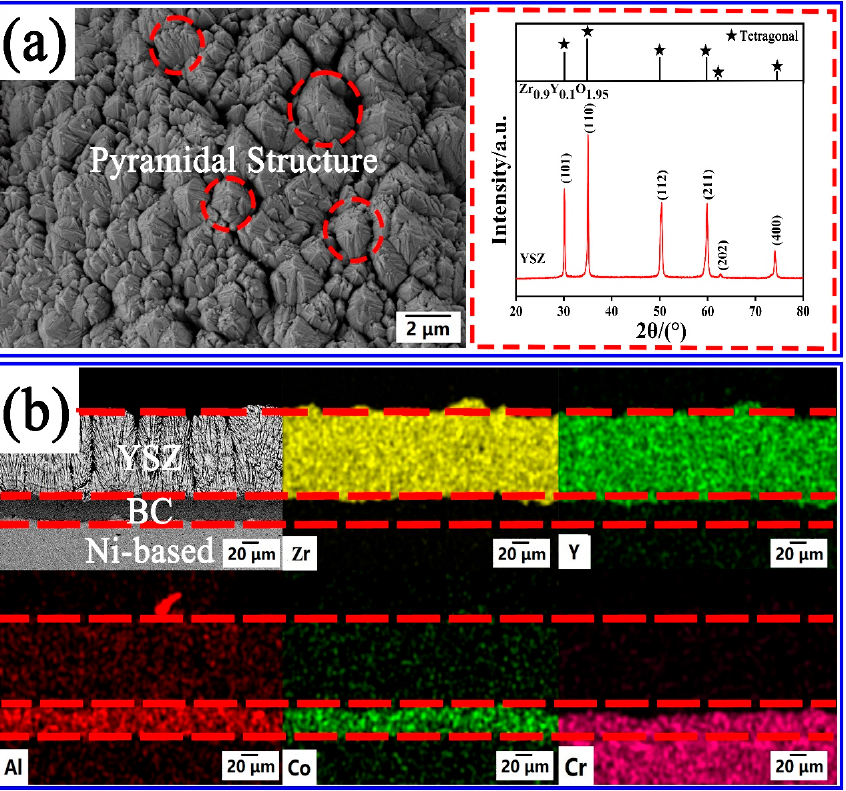
Figure 2. Characterization results of YSZ coating: ( a ) surface morphologies and phase composition; ( b ) cross-sectional morphologies and corresponding EDS maps.